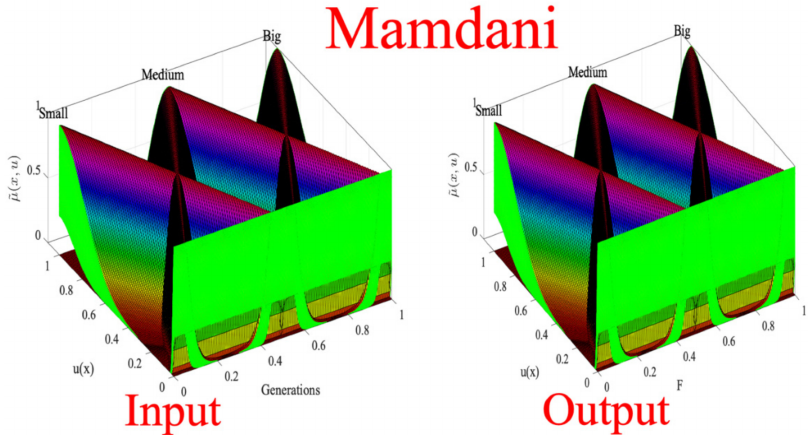
Figure 2. Differential evolution algorithm with interval type-3 fuzzy set (IT3FDE).